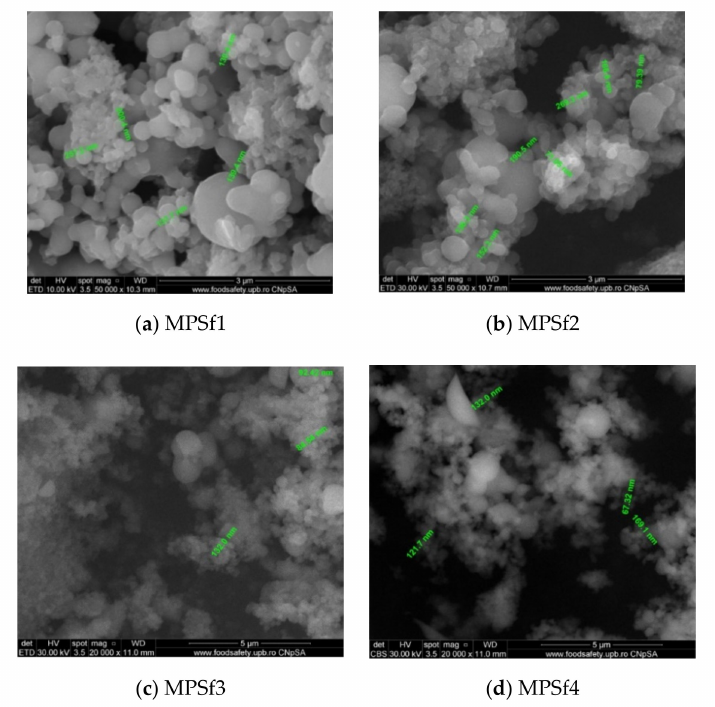
Figure 12. Morphology and dimensions of micro- and nanoparticles in the membrane section.